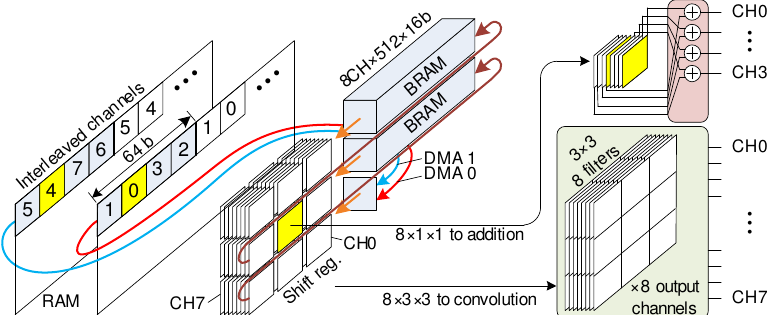
Figure 10. Data transfer to a multi-channel 3 × 3 sliding window and a convolution/addition